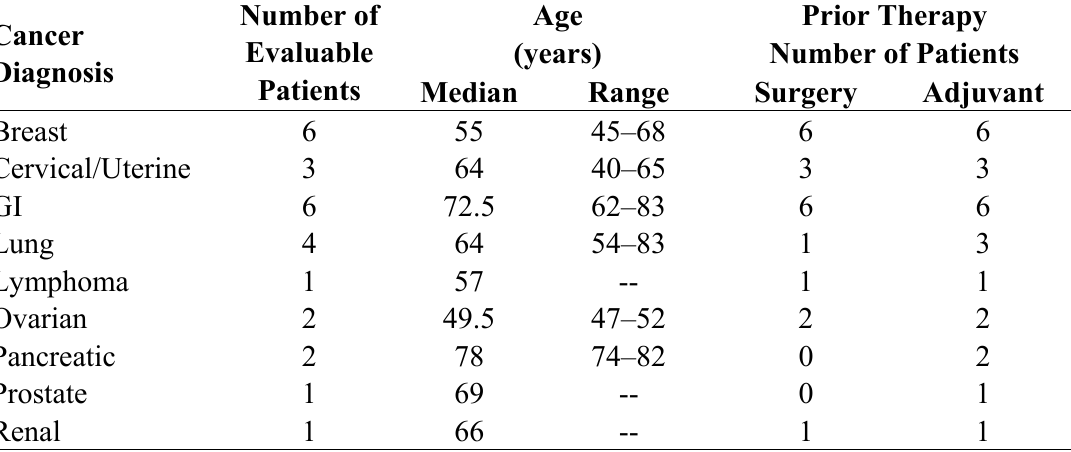
Table 2. Patient demographics, clinical diagnosis, and prior